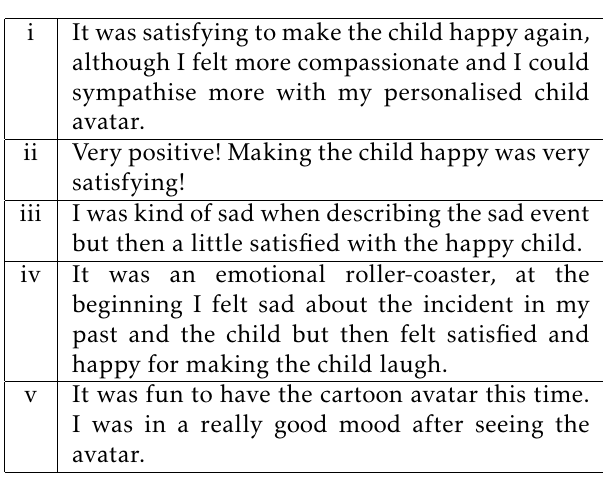
Figure 9. Overall percentage selection for questions Q8 to Q12 in Table 4. Table 6. Answers to Q13 in Table